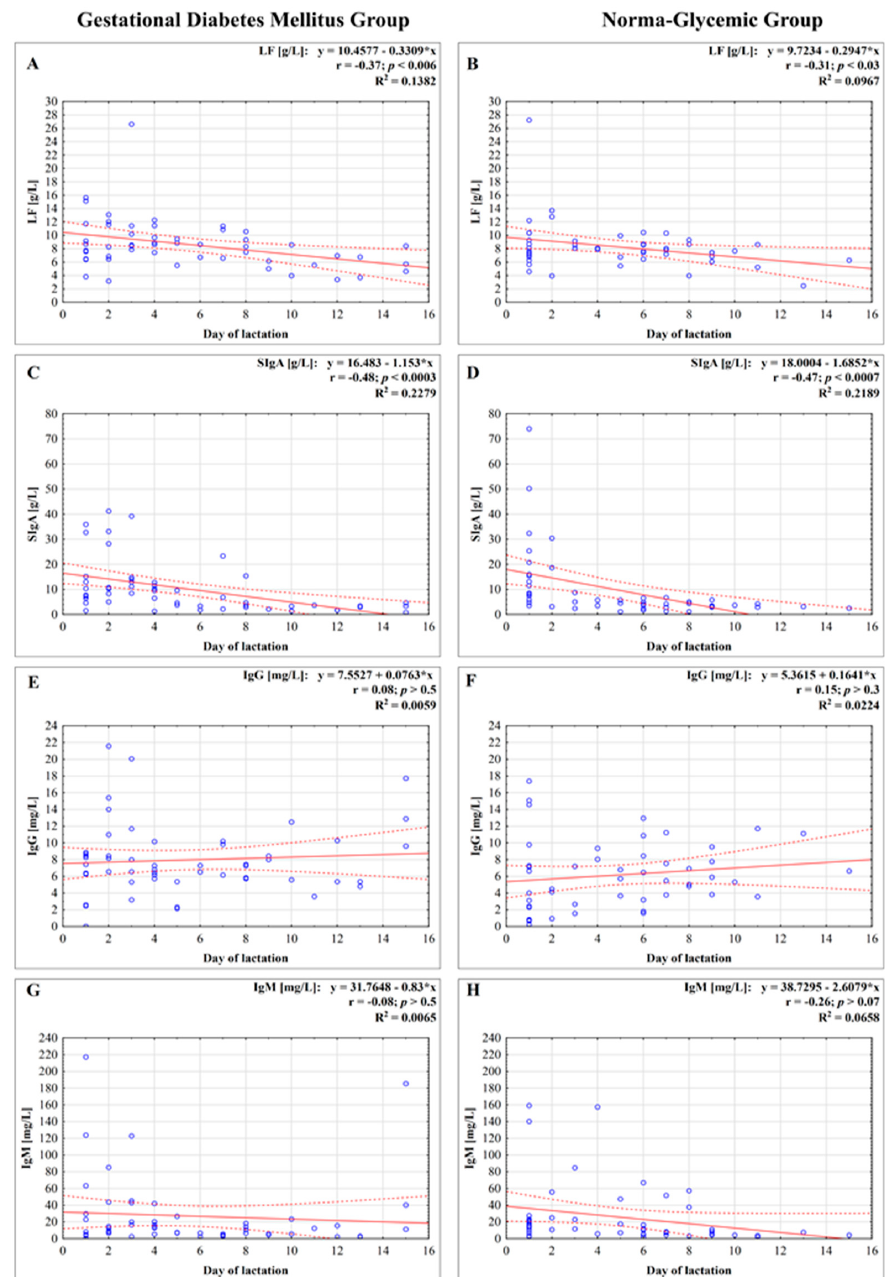
Figure 1. Concentration of lactoferrin ( A , B ), secretory immunoglobulin A (SIgA) ( C , D ), immunoglobulin G (IgG) ( E , F ), and immunoglobulin M (IgM) ( G , H ) in milk in the first two weeks of lactation from mothers with gestational diabetes mellitus (GDM) and normoglycemic mothers. A solid line indicates linear regression, and 95% confidence intervals are shown by dotted lines; blue circles refer to individual samples. The correlation coefficient ( r ) was calculated according to Spearman, and a p -value lower than 0.05 was regarded as significant. The r -square value is the square of the correlation coefficient. NS, not significant.